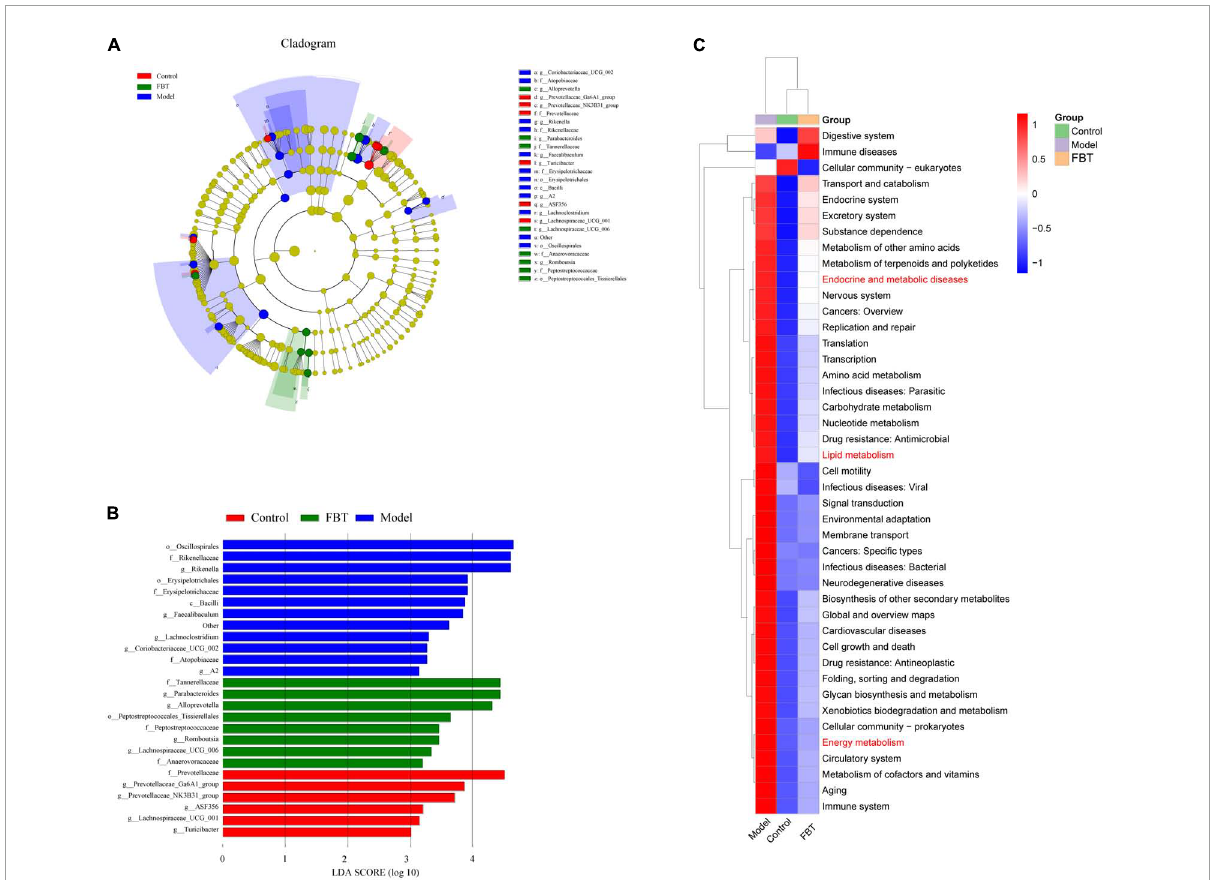
FIGURE5 Effects of FBT on gut key microbiota and microbiota biological function of NAFLD mice. (A,B) FBT treatment altered key microbiota of the gut in NAFLD mice; (C) the differential metabolic pathways of FBT on NAFLD were predicted using PICRUSt